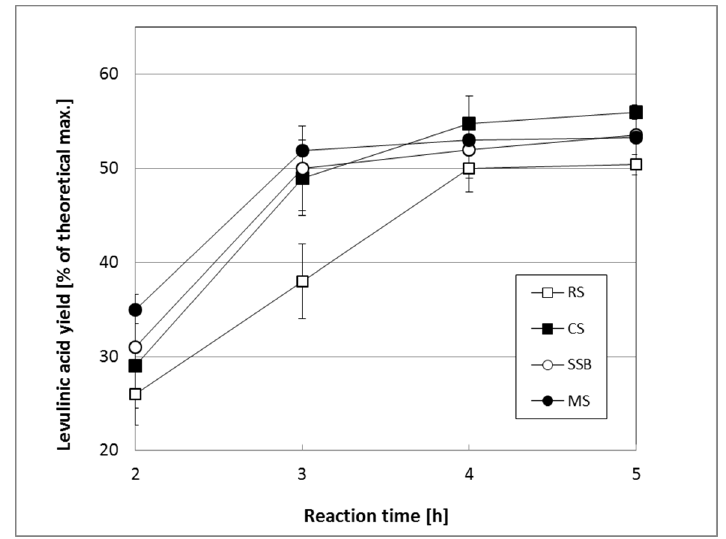
Figure 4. Effect of reaction time on LA production using delignified RS, CS, SSB and MS. Note . Particle size >2000 µm; reaction conditions: 1 M HCl, 150 °C, 50 g/L solid loading.